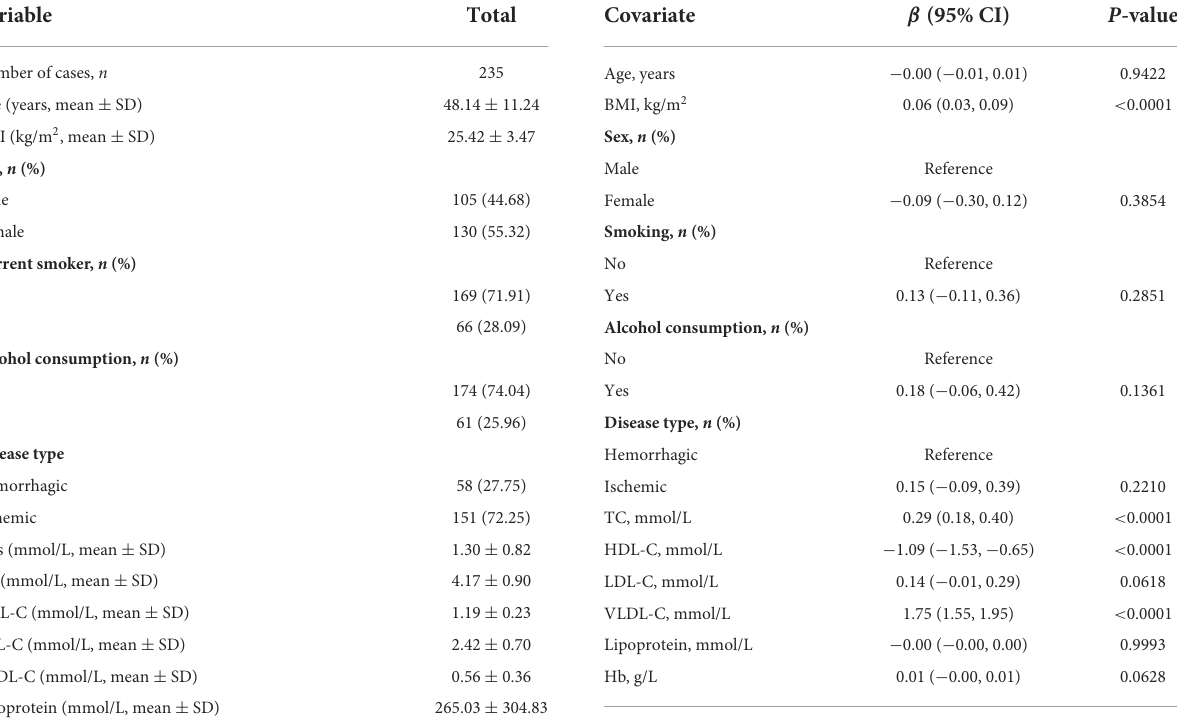
TABLE 1 Clinical characteristics of the study population. TABLE 2 Univariate analysis for TGs